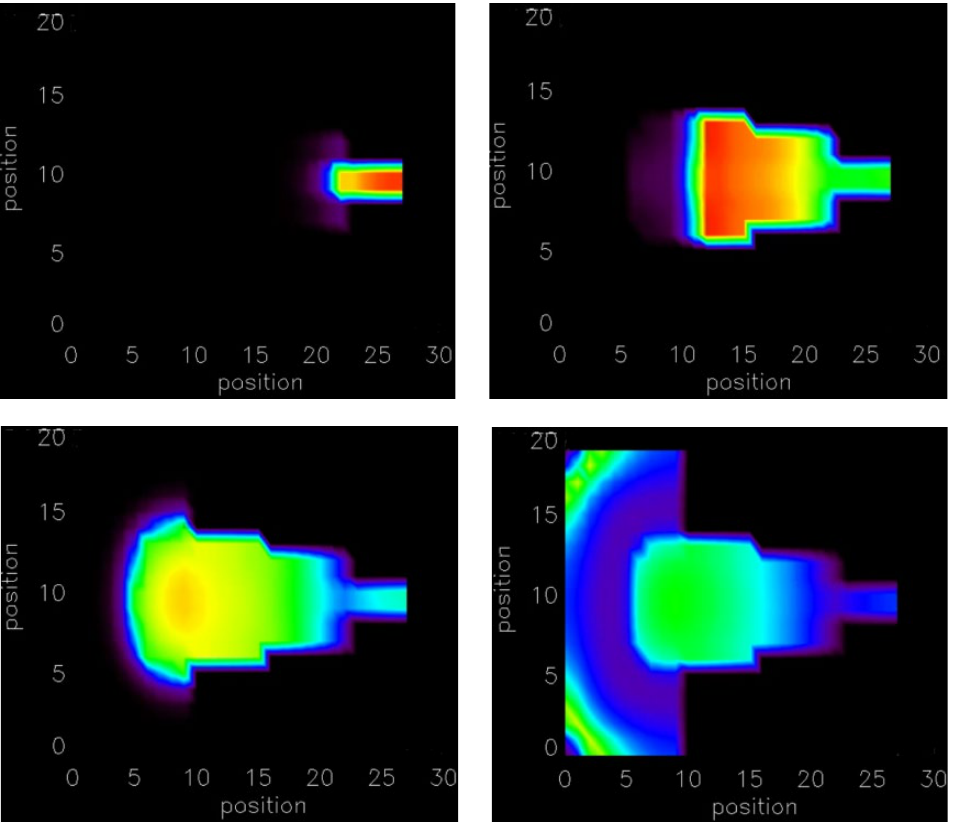
Figure 6. By injecting current results in a propagating action potential at along the line of 2 × 2 × 5 myocytes. The movies of the simulation are available in Supplementary videos S5 and S6.